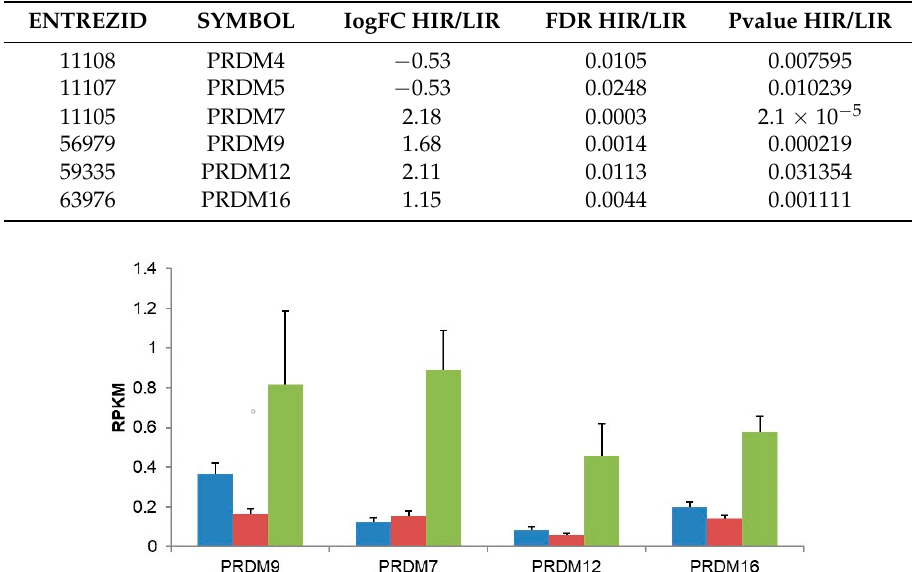
Table 2. Log-transformed fold-changes (logFC) in the expression of the indicated genes in high infertility risk patients before and after gonadotropin-releasing hormone agonist treatment.